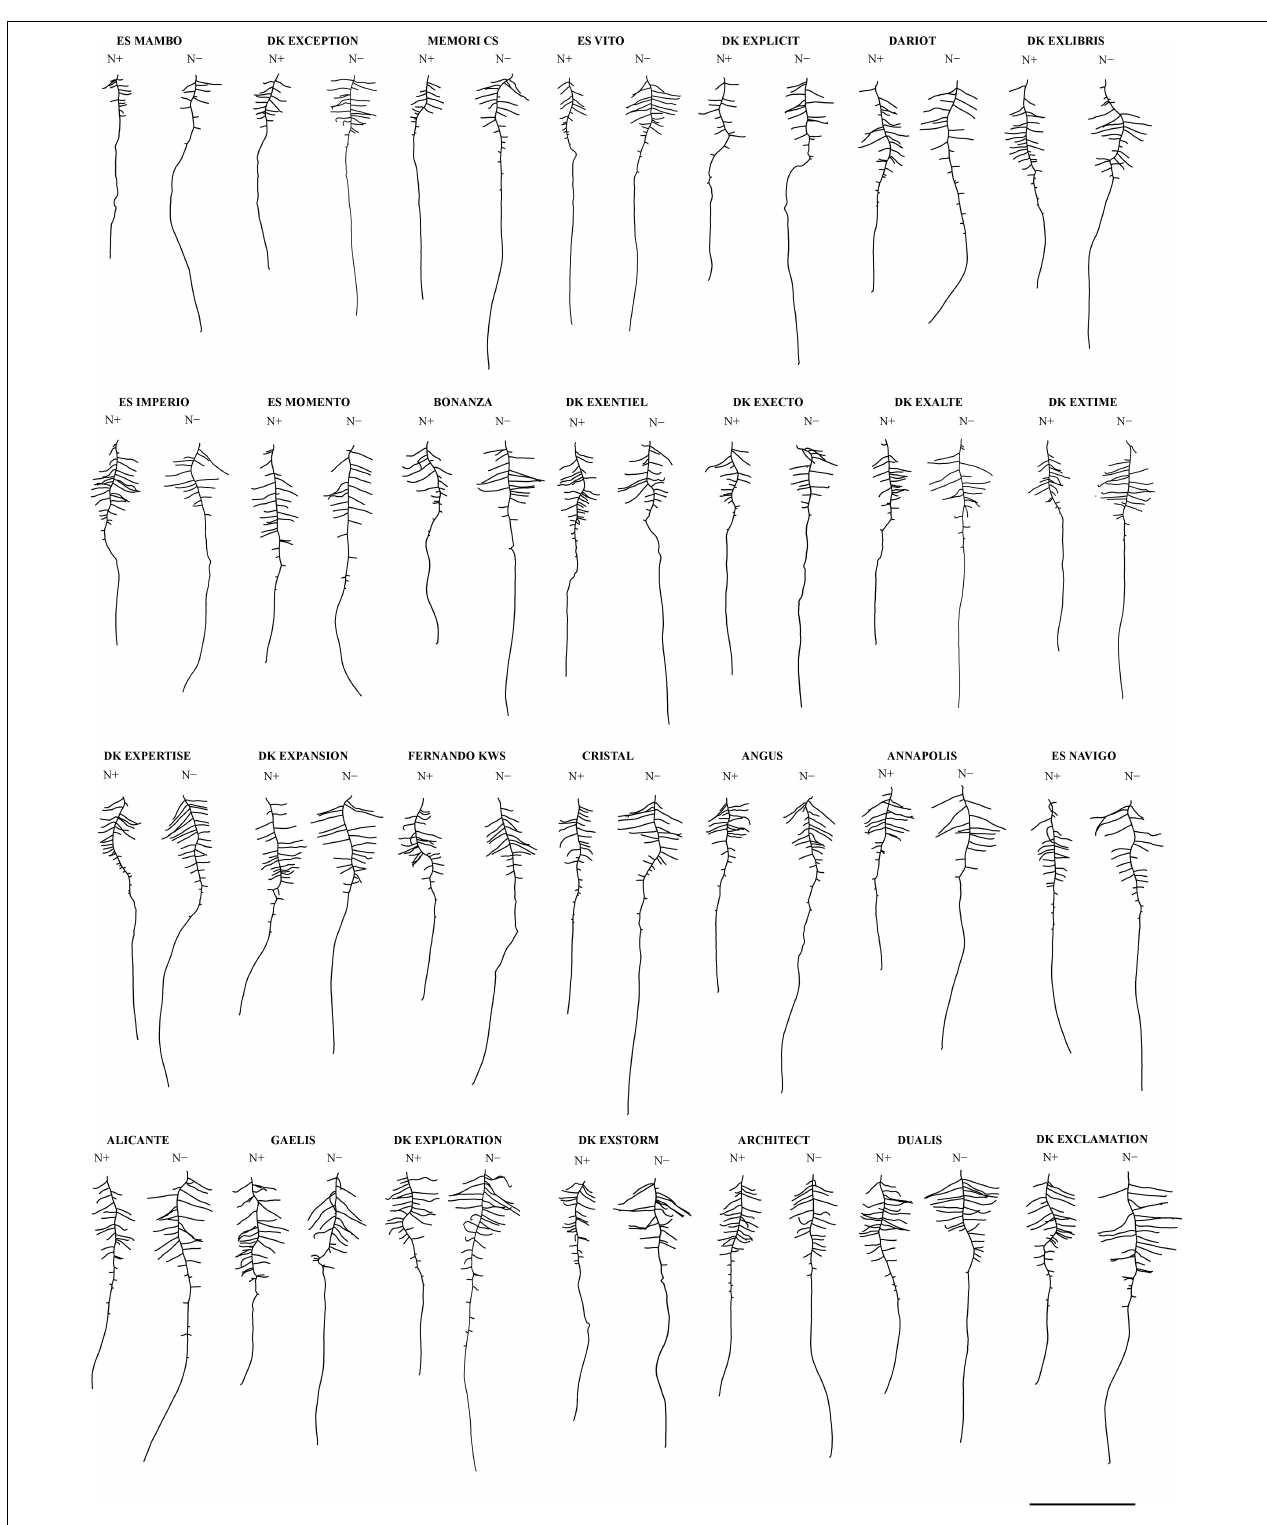
FIGURE 1 | Representative root morphologies of 28 winter oilseed rape cultivars grown in hydroponics. Seedlings grew in the hydroponic pouch-and-wick system with 0.2 mM (N–) or 5.0 mM (N+) nitrate supplies (12 seedlings observed). Representative items for each cultivar-N concentration pair were selected from individuals being closest to the median value for both the primary root length (LPR) and the total root length (TRL). Cultivars are ordered by increasing total root length (TRL) measured at N–. Scale bar = 5 cm.